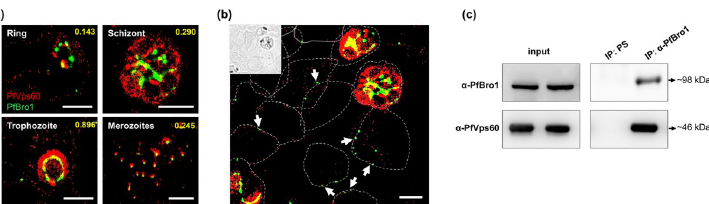
Fig 4. Interaction between PfVps60 and PfBro1. (a) STORM immunostaining detection of PfVps60 and PfBro1 in the blood stages of P . falciparum . (b) Field showing non-infected and infected RBCs. The inset contains a bright field low-resolution image to show the non-infected RBCs. Arrows pinpoint extracellular vesicles bound to non-infected RBCs, whose contours are indicated by dashed lines. Scale bars: 2 μ m. (c) Immunoprecipitation of pRBC lysates at 30 hpi using anti-PfBro1 antibodies or preimmune serum